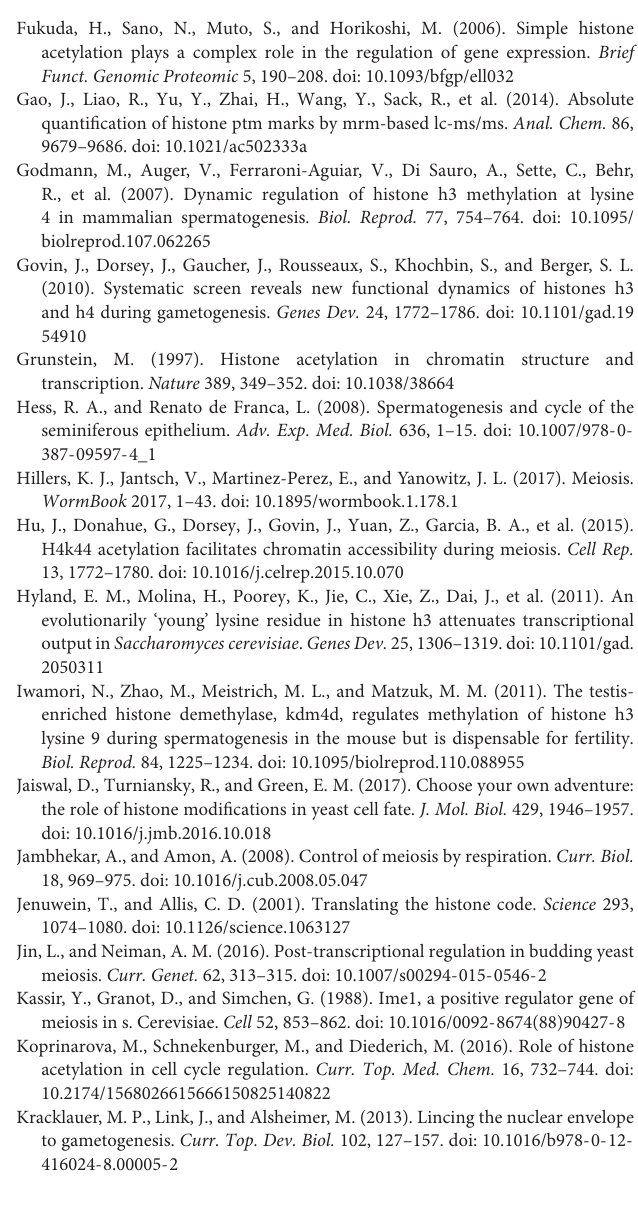
Supplementary Figure 1 | The comparison of histone modifications which show similar dynamic trends in mouse spermatogenesis and yeast sporulation. H3K4me1, H3K4me2, and H3K18me1 showed similar changes in both mouse and yeast during meiosis. Supplementary Figure 2 | Western blot verification of the construction of histone H3 K to A mutant strains. (A) The K to A mutant histone H3 could be expressed. Pgk1p was used as a loading control. (B) The original histone H3 could not be